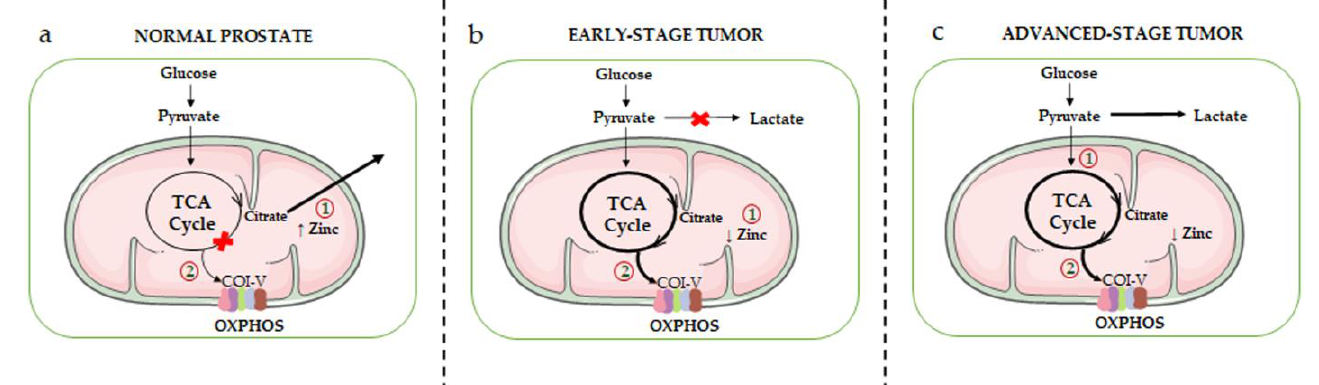
Figure 1. Schematic overview of the mitochondrial metabolic rewiring occurring in prostate epithelial cells during the different stages of cancer progression. ( a ) Healthy prostate epithelial cells accumulate high levels of zinc (due to the overexpression of its transporter ZIP1), resulting in the inhibition of mitochondrial m-aconitase, the key enzyme responsible for the citrate-isocitrate conversion in the TCA cycle (1). This inhibition ultimately leads to the truncation of the TCA cycle and to citrate accumulation and secretion. As a result, normal prostate epithelial cells are characterized by an inefficient OXPHOS machinery (complexes I-V, COI-V) (2). ( b ) In the early stage of tumor progression, intracellular zinc levels are significantly reduced (due to a decreased expression of its transporter) (1); this leads to the reactivation of m-aconitase, restoring the citrate-isocitrate conversion, and consequently of the TCA cycle and OXPHOS metabolic pathways (2). ( c ) In the advanced stage of tumor progression, PCa cells exhibit the Warburg effect, an active aerobic glycolysis accompanied by high levels of lactate production (1). However, it is now well established that a high activity of the TCA cycle/OXPHOS pathways still persists in these cells, and it is even exacerbated in PCa stem cells as well as in drug-resistant PCa cells (2).